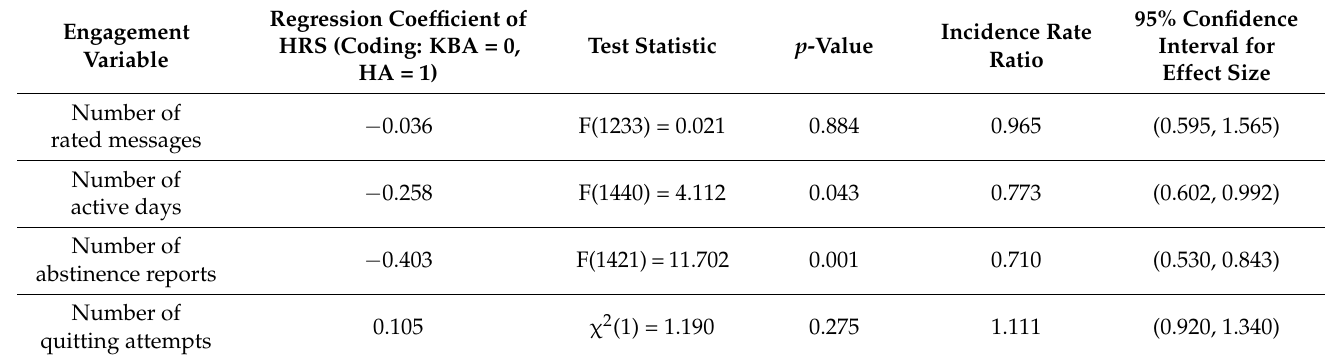
Table 4. Comparison between the two HRS groups of their results for main effects on engagement variables for non-dropouts over the time period of 0–180 days.